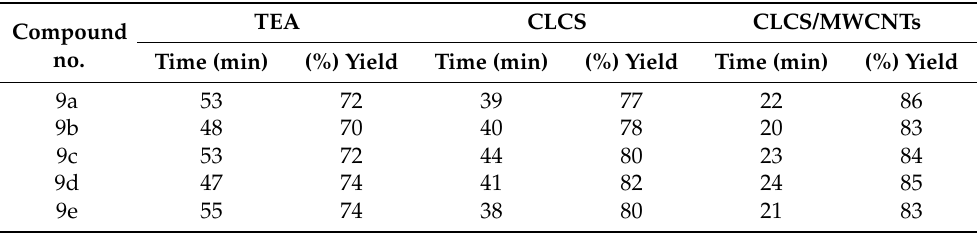
Table 3. Comparison of synthesis of bis-thiazoles 9a – e under ultrasound irradiation using a different basic catalyst according to the time of reaction and the yield % of the products. Compound